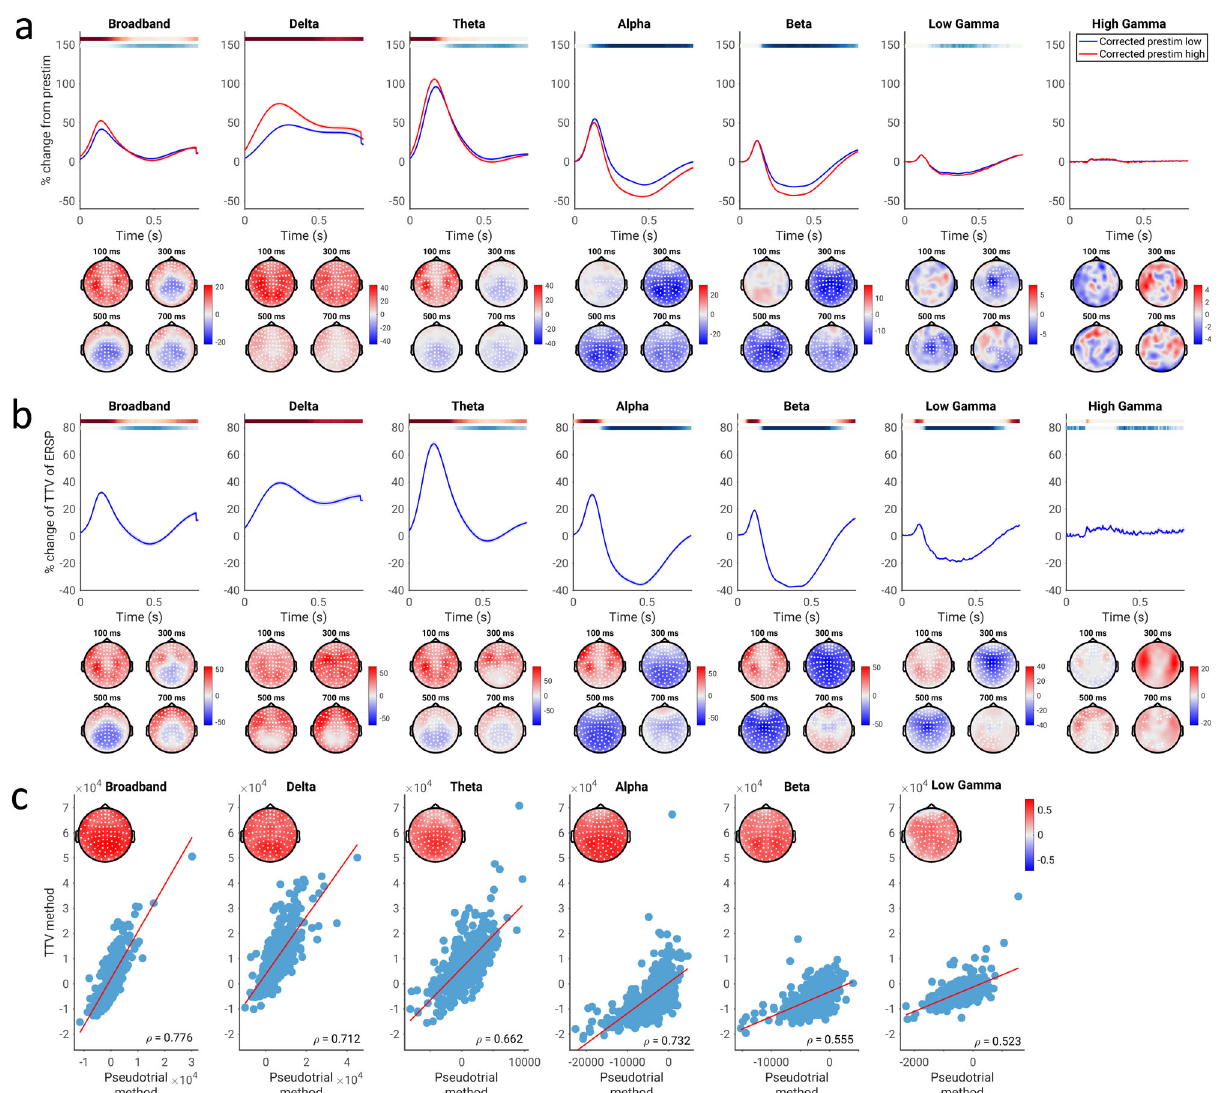
Fig. 2 Correlation between spontaneous and evoked spectral power, assessed using the pseudotrial method and TTV method in the CamCAN dataset. a Pseudotrial-corrected time courses for high prestimulus (red) and low prestimulus (blue) conditions. Line shows mean across all sensors and subjects, shaded area indicates standard error of the channel-average time course across subjects. Effect topographies are shown at 100 ms, 300 ms, 500 ms, and 700 ms; white dots indicate sensors which are part of a signi fi cant cluster. Shaded overbars indicate the signi fi cance of the difference between prestim high and low conditions. The shade of the bar indicates the percent of sensors which are part of a signi fi cant cluster at any given time point (i.e., darkest = all sensors part of cluster, lightest/white = no sensors part of cluster); red indicates positive clusters (prestim high > prestim low), blue indicates negative clusters. b Time course of TTV in each frequency band, expressed in terms of percent change from prestimulus levels. Lines, overbars, and topographies as in a): red overbars indicate clusters with TTV increases, blue overbars indicate TTV decreases. c Across-subject correlation of the magnitude of spontaneous-evoked relationship found using each method. Scatter plots show the correlation of the mean values of the summary indices across all electrodes, while the topoplots show the correlations at each electrode, with white dots indicating signi fi cance following the cluster test. N = 474